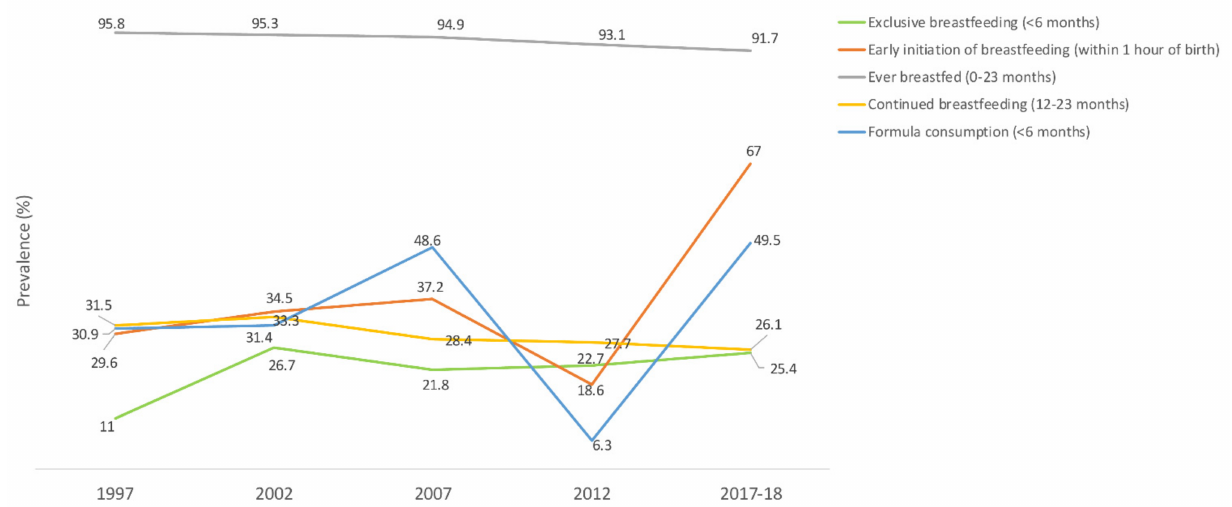
Figure 1. Trends in the prevalence (%) of breastfeeding indicators in Jordan, national surveys (1997–2017/18). Source: UNICEF, 2021; Neves et al., 2021